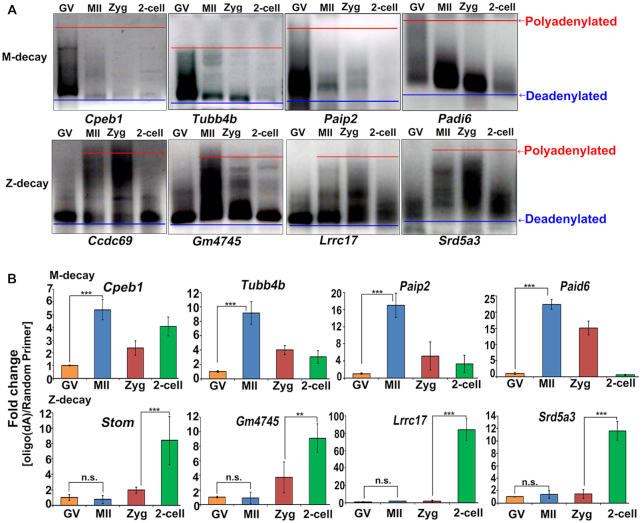
Dynamics of 3′-terminal polyadenylation and oligouridylation in maternal transcripts undergoing M-decay and Z-decay. (A) Poly(A) tail assay results showing changes in the poly(A)-tail length tendency of indicated M-decay and Z-decay transcripts during MZT. Zyg, zygote. Experiments were performed three times with reproducible results; a representative result is shown. (B) Changes in RT-qPCR results obtained with oligo-(dA)- versus random primer-mediated RT reactions reflecting the 3′-oligouridylation levels of selected M-decay and Z-decay transcripts during MZT. Zyg, zygote. Error bars, s.e.m. ***P < 0.001 by two-tailed Student's t-test. n.s.: non-significant. n = 3 biological replicates.